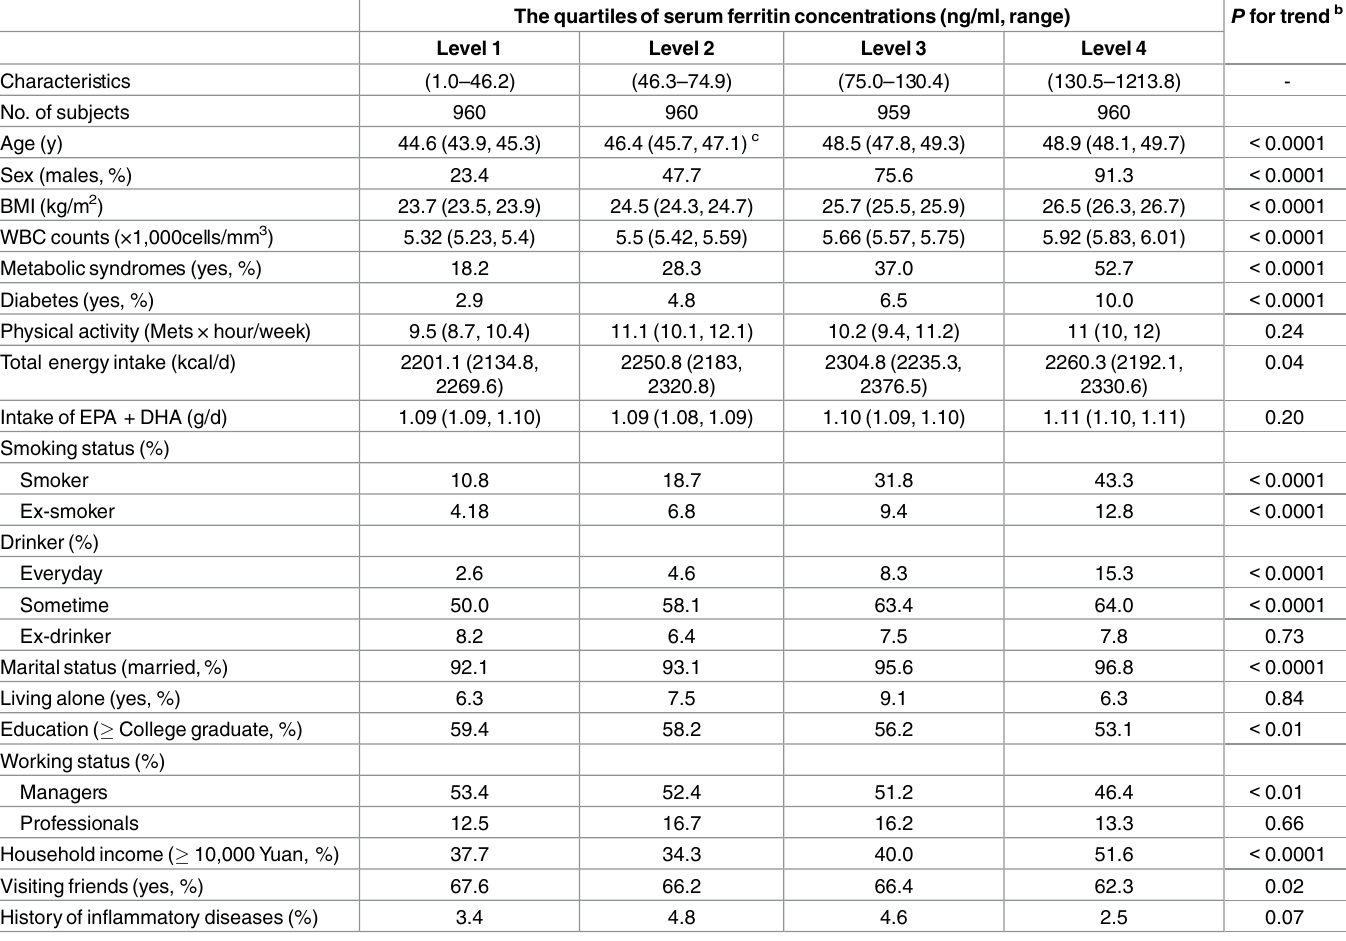
Table 1. Participantcharacteristicsaccording to the quartilesof serum ferritinconcentrations (n = 3,839) a . The quartilesof serum